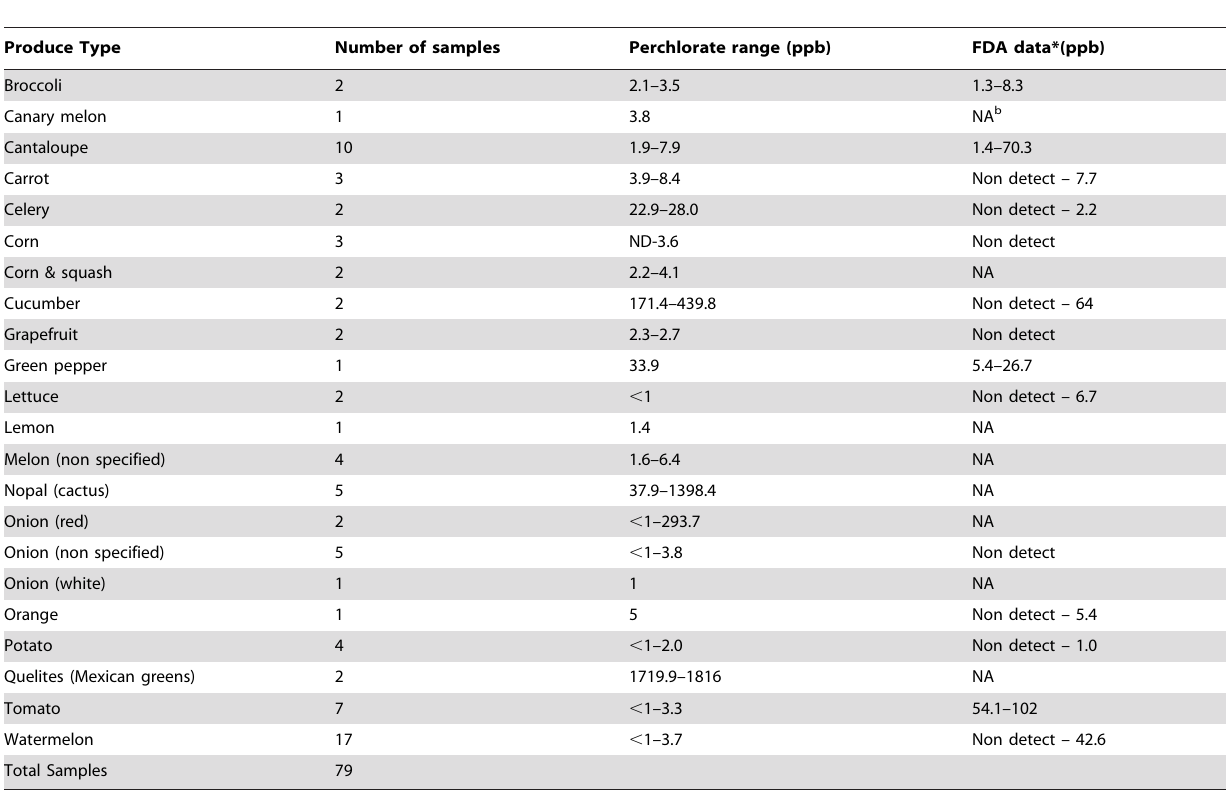
Table 2. Perchlorate levels found in locally grown produce compared to FDA survey levels, a Imperial Valley, CA, 2009.